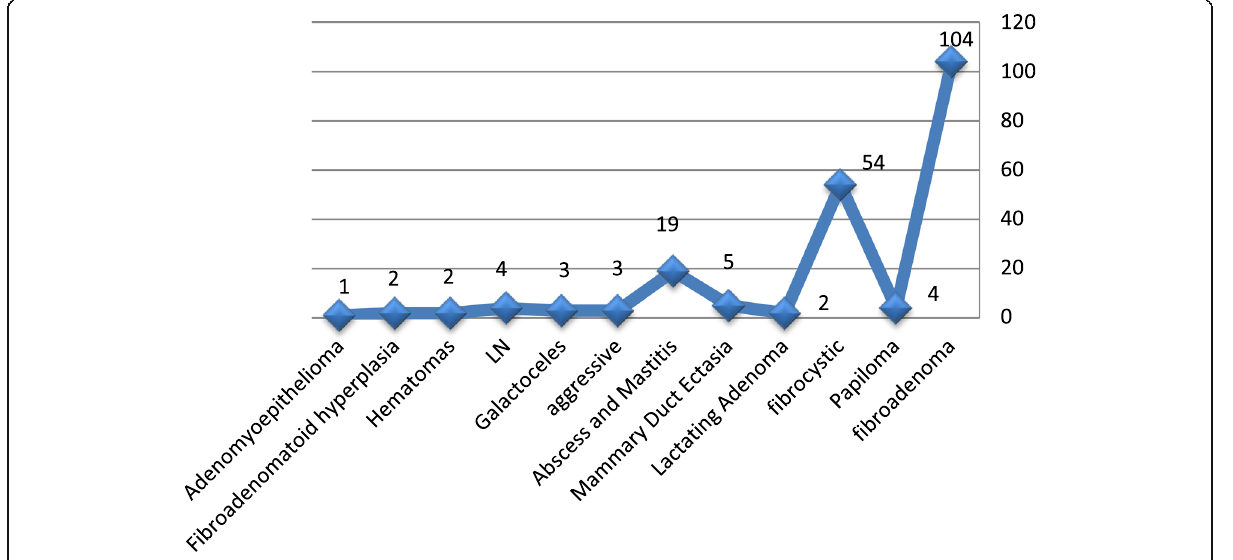
Fig. 1 Frequency of the breast lesion in the examined young